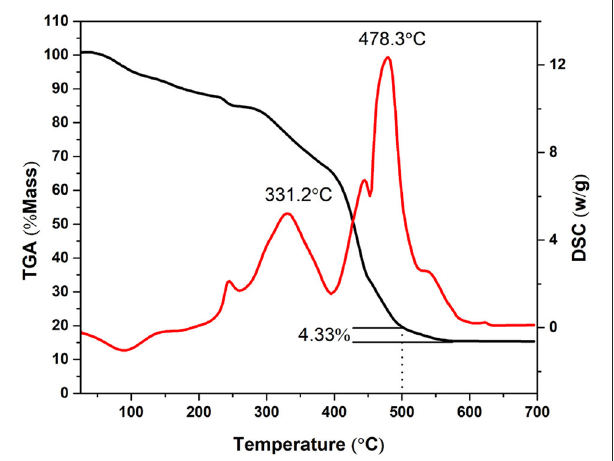
FIGURE 3 | Thermogravimetric analysis results of the KVO precursor nanofibers in air from room temperature to 700 ◦ C. The temperature ramping rate was 10 ◦ C min − 1 .